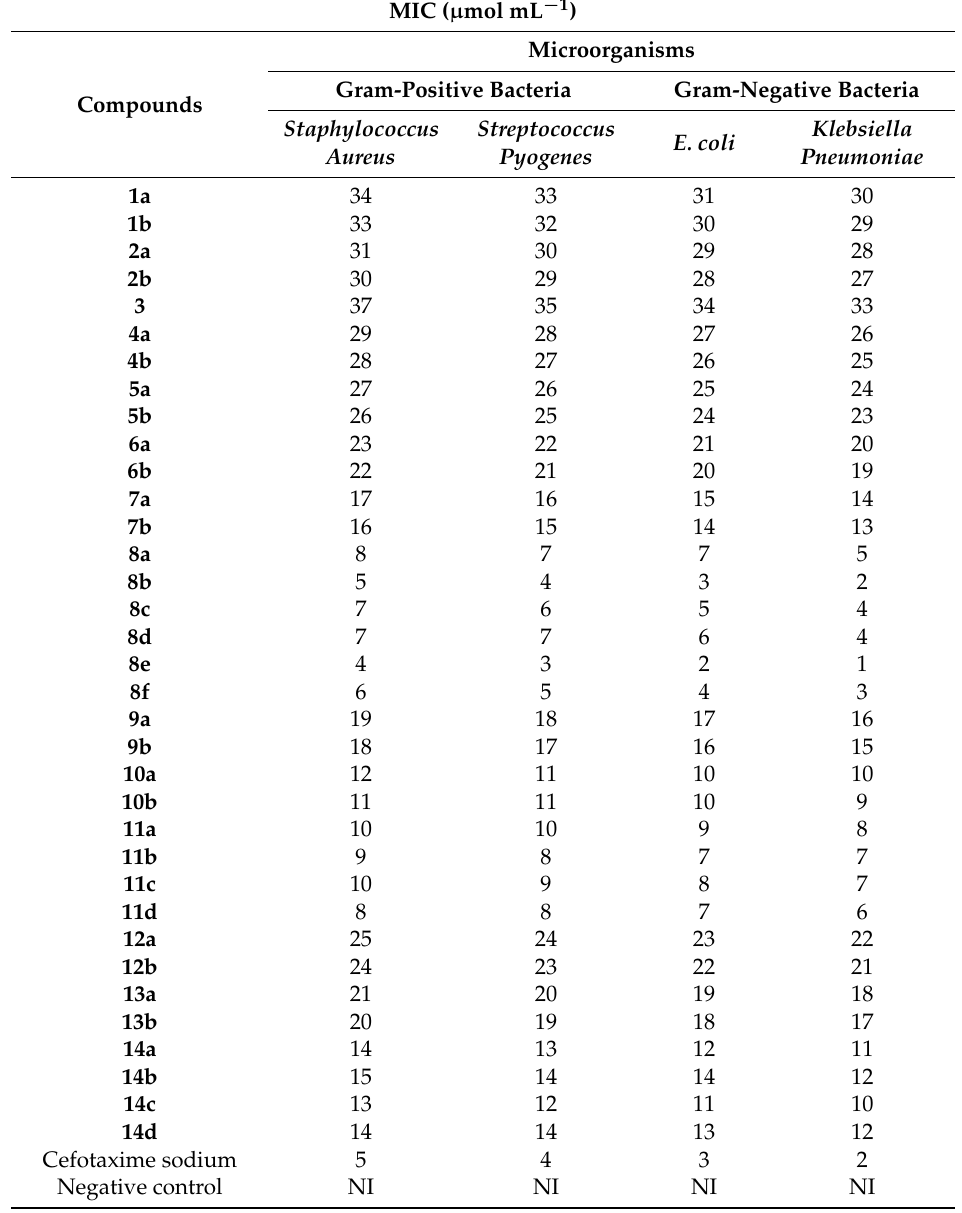
Table 1. A minimum inhibitory concentration of the compounds against bacteria.